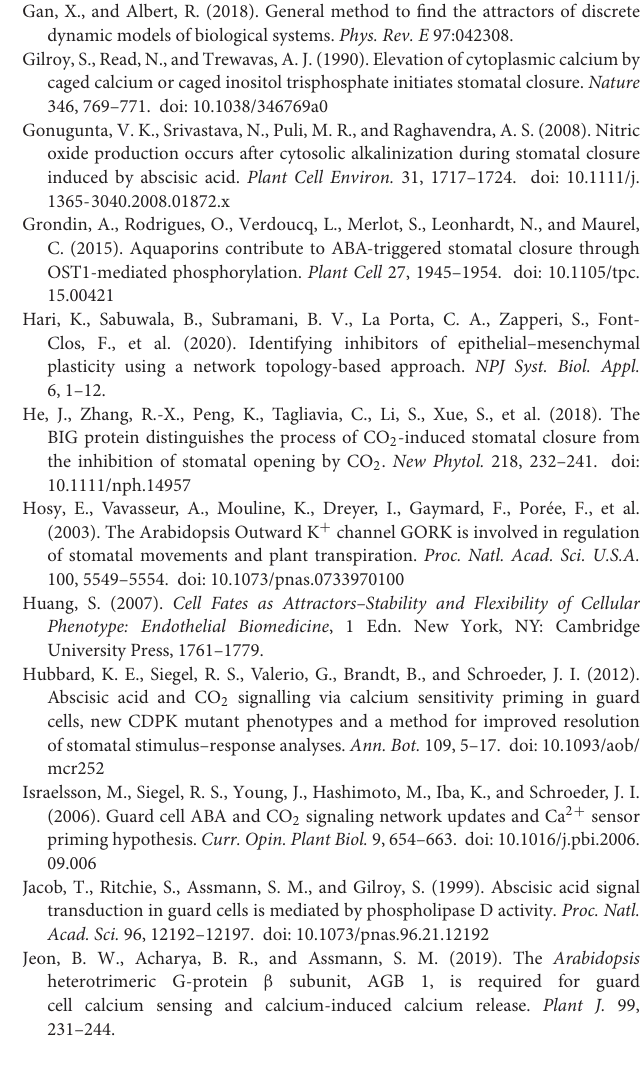
TABLE S3 | The Boolean update function of each node in Model1. TABLE S4 | Attractors of Model1 and Model2. TABLE S5 | Attractors of Model1 with short-term memory. TABLE S6 | Simulation results from Model1 and Model2 with short-term memory for constitutive activation of nodes in the absence of ABA for initial conditions that ensure the absence of baseline closure. TABLE S7 | Simulation results for constitutive activation of each node in the absence of ABA in Model1 with short term memory for initial conditions that result in near zero baseline percentage of